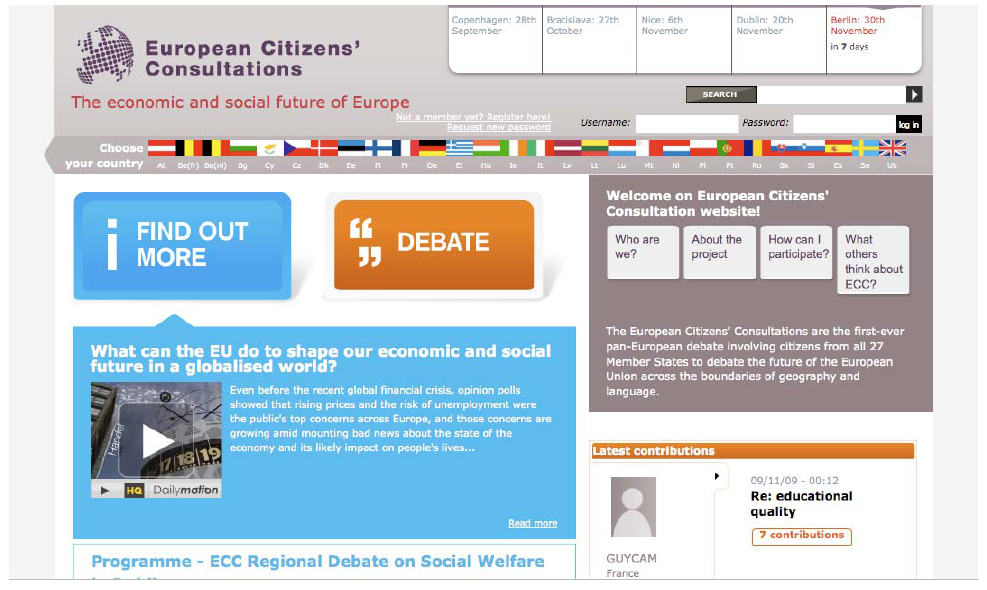
Figure 1: The ECC website (http://www.european-citizens-consultations.eu/, May 2010) Face-to-face debates were then organized at the national level. In each country, a hundred citizens were chosen by opinion-poll institutes in order to set up panels which were representative of each national population. The notion of representativeness is important here: the